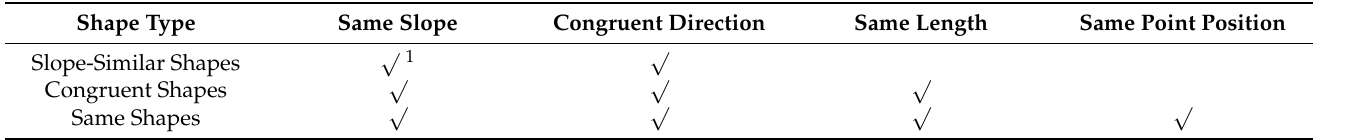
Table 1. Comparison of the three types of shapes.